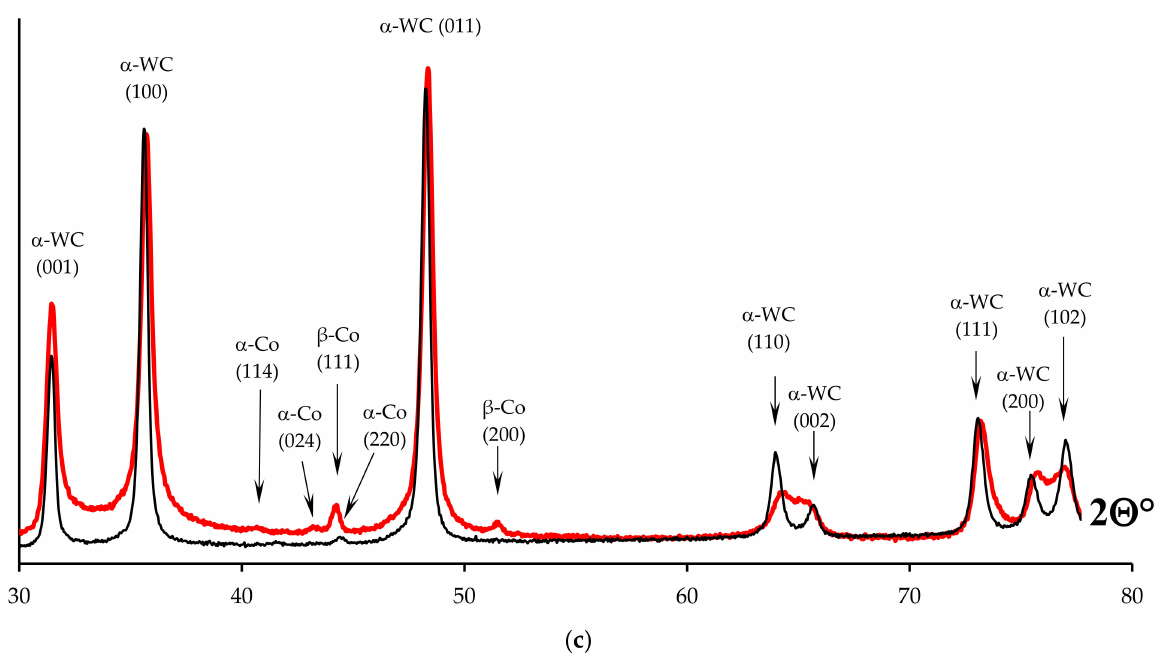
Figure 2. Microstructure ( a , b ) and XRD images ( c ) of α -WC+10 wt.%Co powder compositions: ( a ) submicron powder (Series #1); ( b ) nanopowder (Series #2). In ( c ),the black lines are submicron powders, and the red lines are nanopowders.